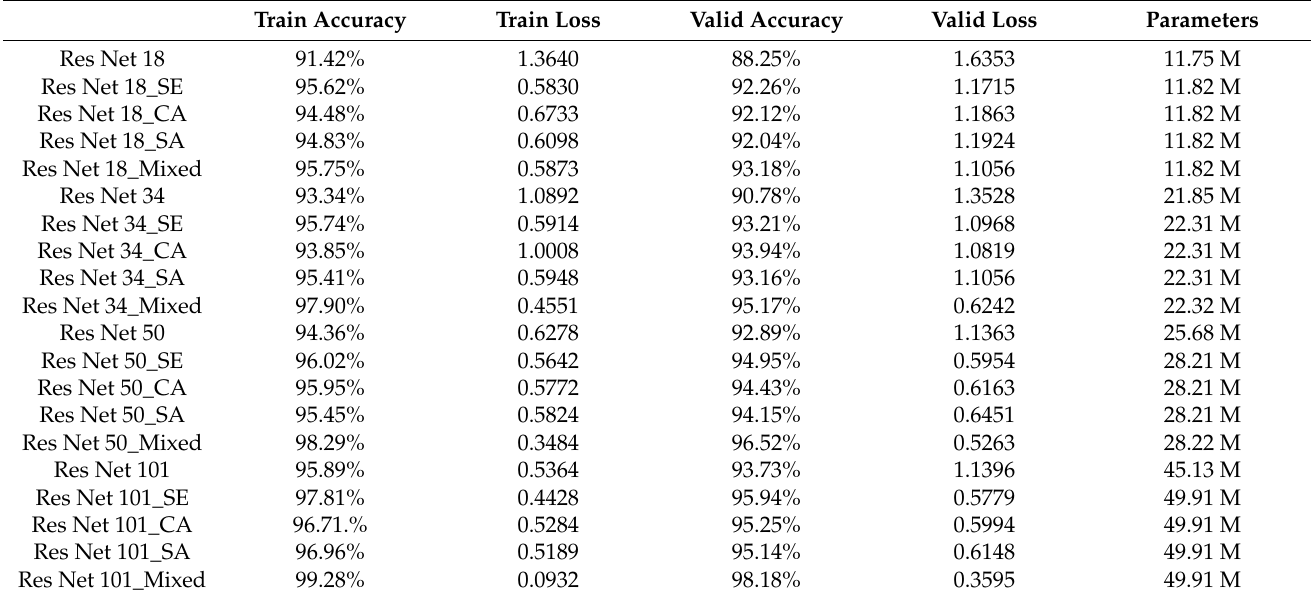
Table 4. Recognition accuracy and efficiency evaluation of ResNet models with different depths by embedding visual attention blocks (especially the mixed visual attention block, greatly improving the recognition accuracy while not affecting the recognition